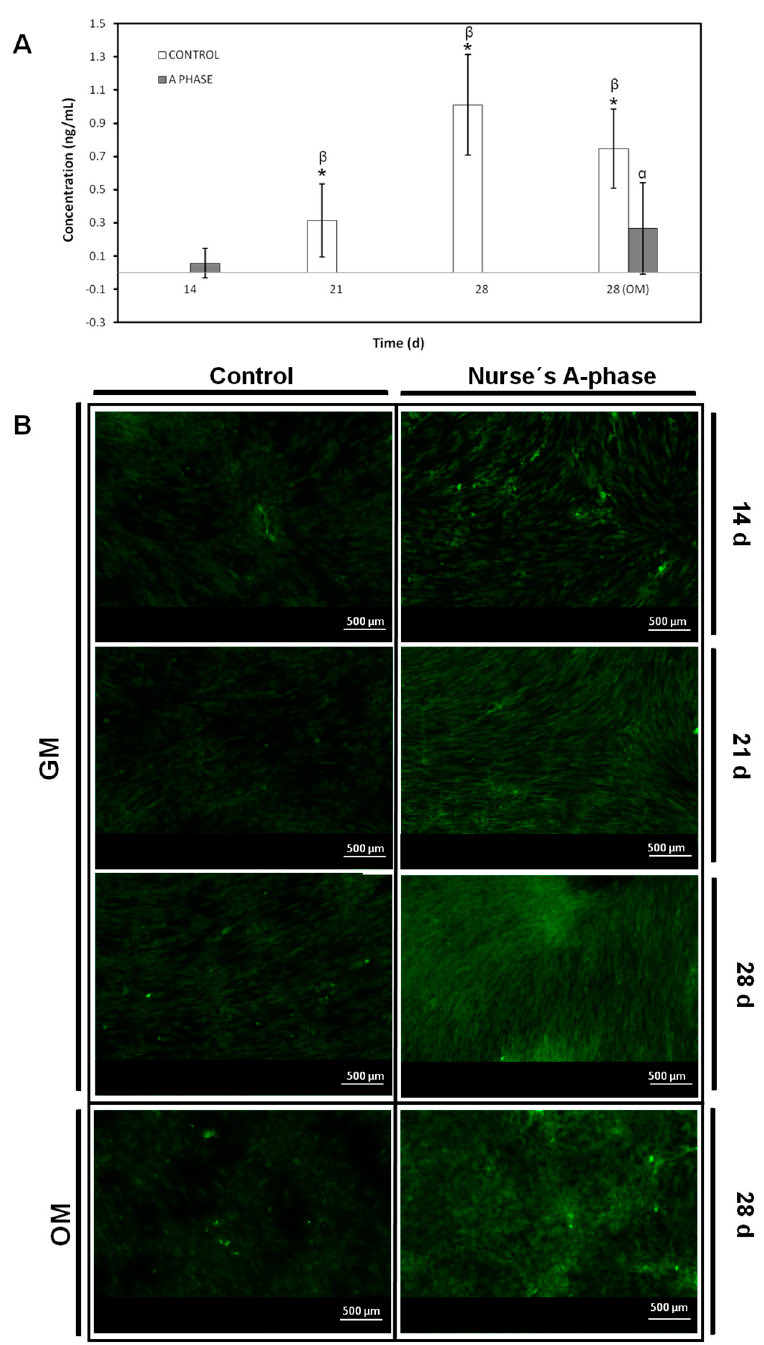
Figure 6. ( A ) Concentration of osteocalcin produced by the cells seeded in indirect contact with A-phase compared to control cells growing on plastic without the presence of the material. (*) denotes significant differences ( p < 0.05) between A phase and control at the same experimental time; ( α ) denotes significant differences ( p < 0.05) between different experimental times obtained for control samples; ( β ) denotes significant differences ( p < 0.05) between different experimental times obtained for cells growing in indirect contact with Nurse’s A-phase scaffolds; ( B ) Immunofluorescence staining of Collagen I images (×5 magnification) of the ah MSCs seeded as control in plastic and cells grown in indirect contact with Nurse’s A-phase ceramic at 14 days, 21 days, and 28 days under different experimental conditions.